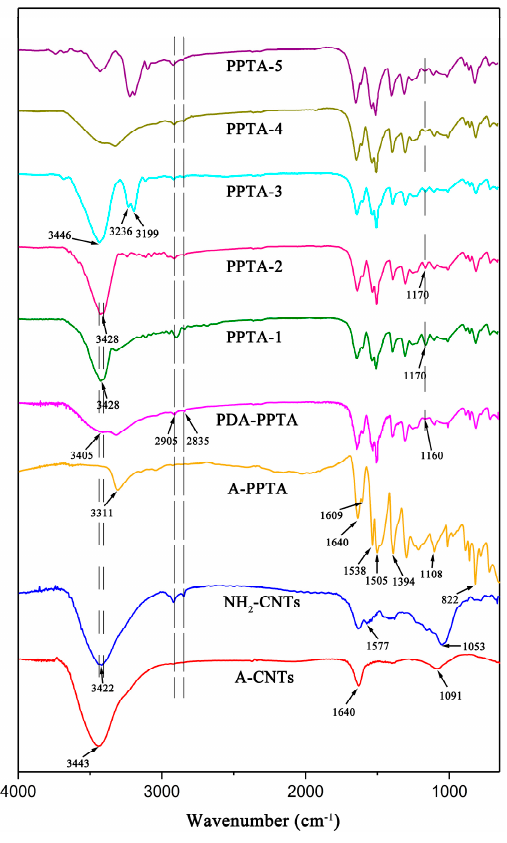
Figure 4. FTIR spectra of CNTs and PPTA fibers.